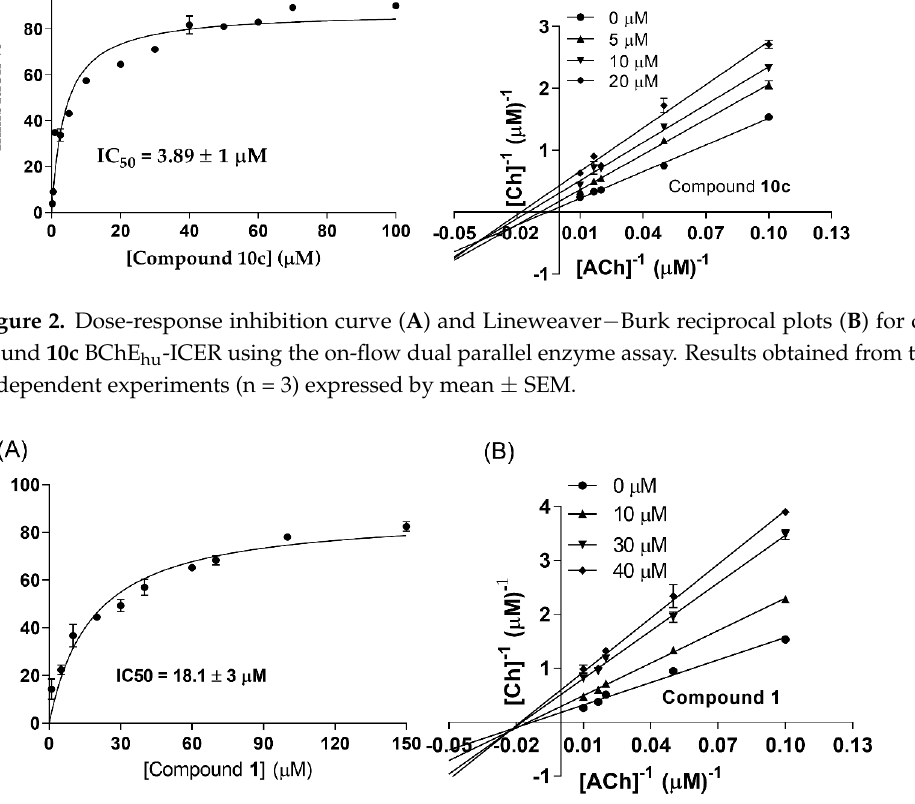
Figure 4. Dose-response inhibition curve ( A ) and Lineweaver−Burk reciprocal plots ( B ) for com- pound 12b BChE hu -ICER using the on-flow dual parallel enzyme assay. Results obtained from three independent experiments (n = 3) expressed by mean ± SEM.